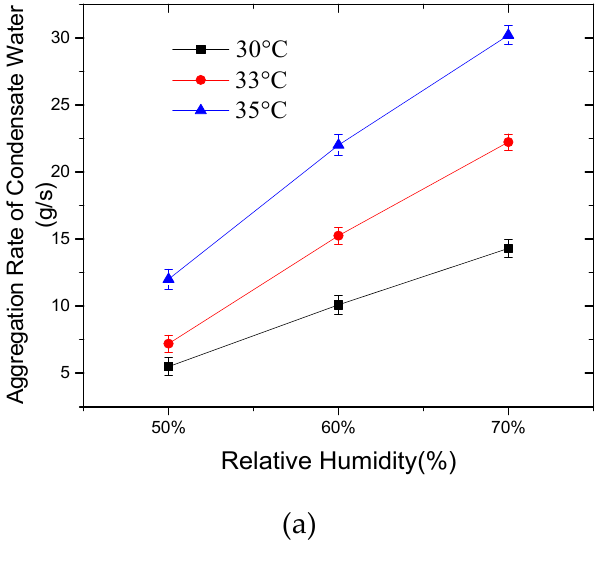
Figure 6. Variation in the overall heat transfer coefficient and air-side heat transfer under different air inlet temperatures ( T a-in ) and relative humidity: ( a ) The overall heat transfer coefficient under different temperatures and relative humidities; ( b ) Air-side heat transfer under different temperatures and relative humidities.